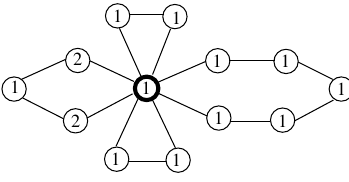
Figure 6: The Dutch windmill graph D ( S ) for S = { C